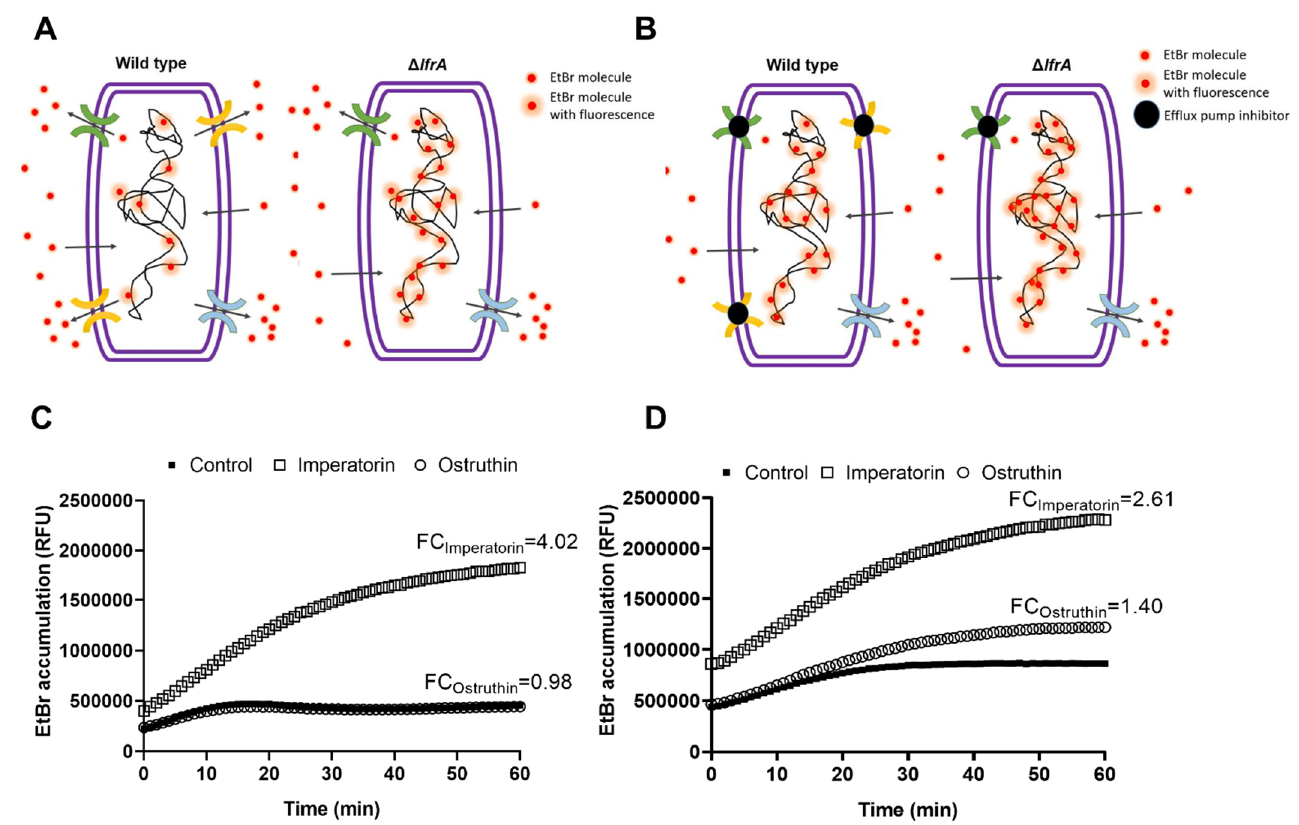
Figure 4. Schematic representation of ethidium bromide (EtBr) accumulation and efflux in M. smegmatis mc 2 155 wild type and ∆ lfrA mutant without inhibitor ( A ) and with efflux pumps inhibitor ( B ); and EtBr accumulation in M. smegmatis mc 2 155 ( C ) and M. smegmatis mc 2 155 Δ lfrA ( D ) untreated culture (control) and treated with the isolated compounds imperatorin ( 4 ) and ostruthin ( 6 ) at the sub-inhibitory concentration of 0.25 × MIC, presented as relative fluorescent units (RFU) with indicated FC in EtBr accumulation in the treated culture vs. the untreated control.